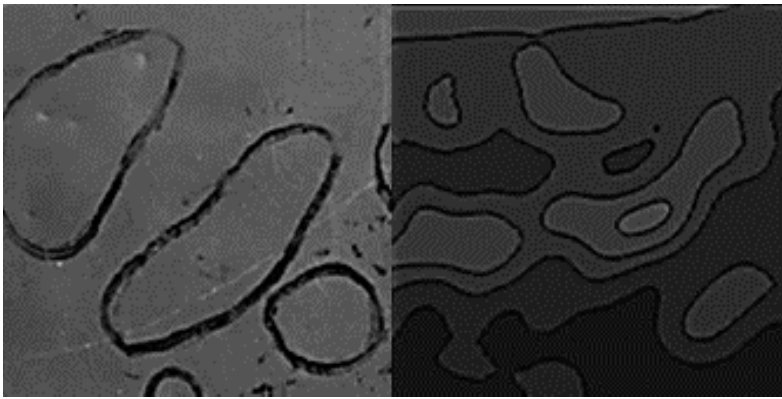
Figure 7. Dent identification comparison; inspection personnel ( left ) vs. ECT method ( right ).